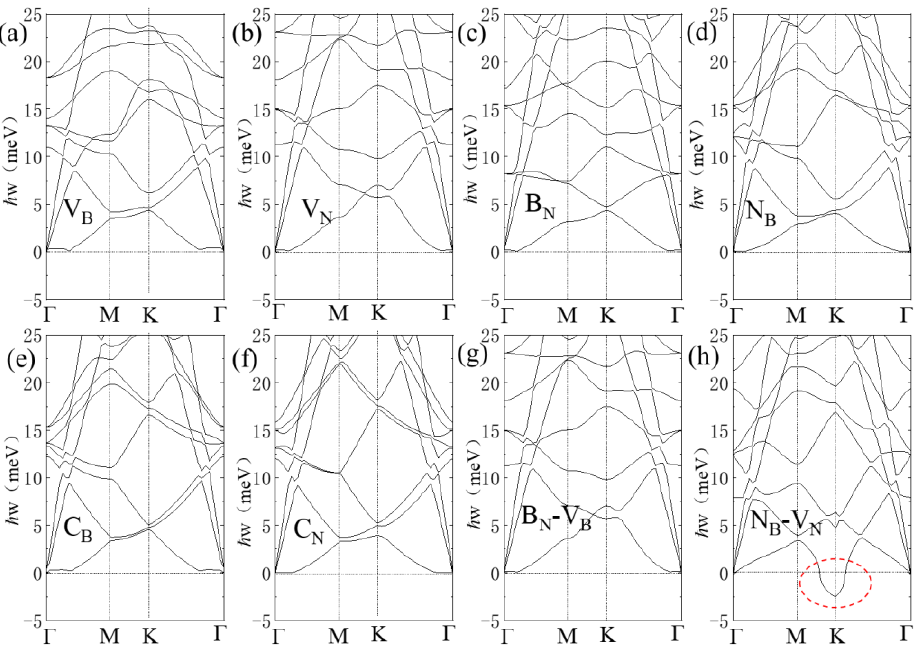
Figure 6. Phonon band structure of hBN monolayer with different defects. ( a ) V B , ( b ) V N , ( c ) B N , ( d ) N B , ( e ) C B , ( f ) C N , ( g ) B N -V B , and ( h ) N B -V N.